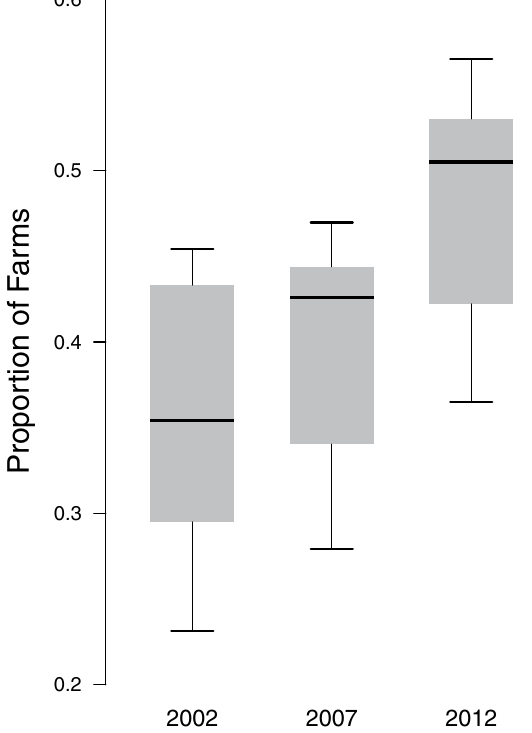
Figure 3. Increase in the proportion of United States farms co-occurring with wild pigs over the ten years we investigated. Boxplots represent the interquartile range (gray box) with the median noted as a solid line, and the whiskers indicate the minimum and maximum of the